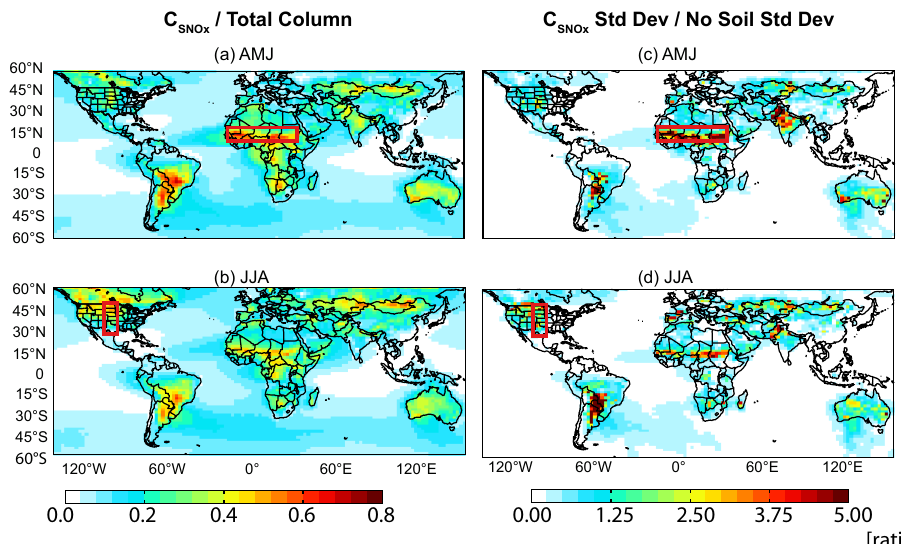
Fig. 5. Sensitivity of simulated tropospheric NO 2 column densities to NO x emissions from soils for late spring and summer. Shown are (a, b) the mean simulated contribution of soil NO x emissions to the tropospheric NO 2 column and (c, d) the ratio of the soil-derived NO 2 column ) standard deviation to the simulated tropospheric NO 2 column standard deviation without soil NO x emissions. C S ( C S NOx the difference in the tropospheric NO 2 column between a simulation with and without soil NO x emission. Boxed regions show the Sahel region of northern equatorial Africa and the Great Plains agricultural center of the United